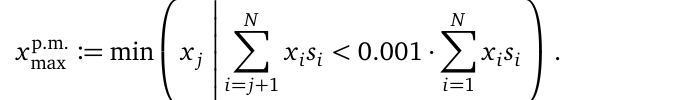
Figure 3: Distribution of weights using 1M test points generated with S HERPA for the process g g → e − e + g gd ¯ d in proton–proton collisions at dimensional histogram of the ratio x = w the reduced weight maxima x p.m. histogram showing the relationship between the ratio x = w weight w